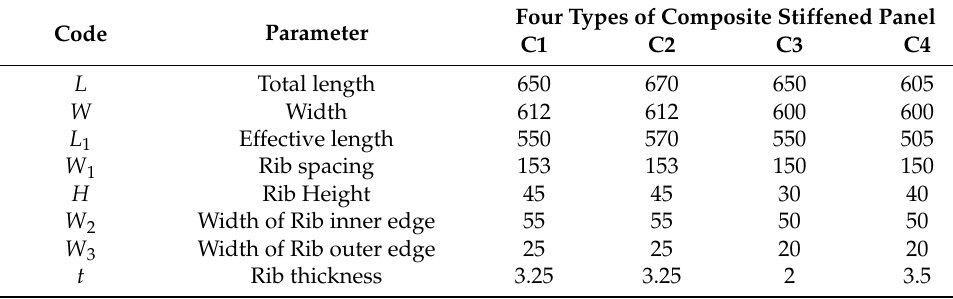
Figure 1. Schematic diagram and physical drawing of the specimen. Table 1. The dimensions of specimens (unit: mm).